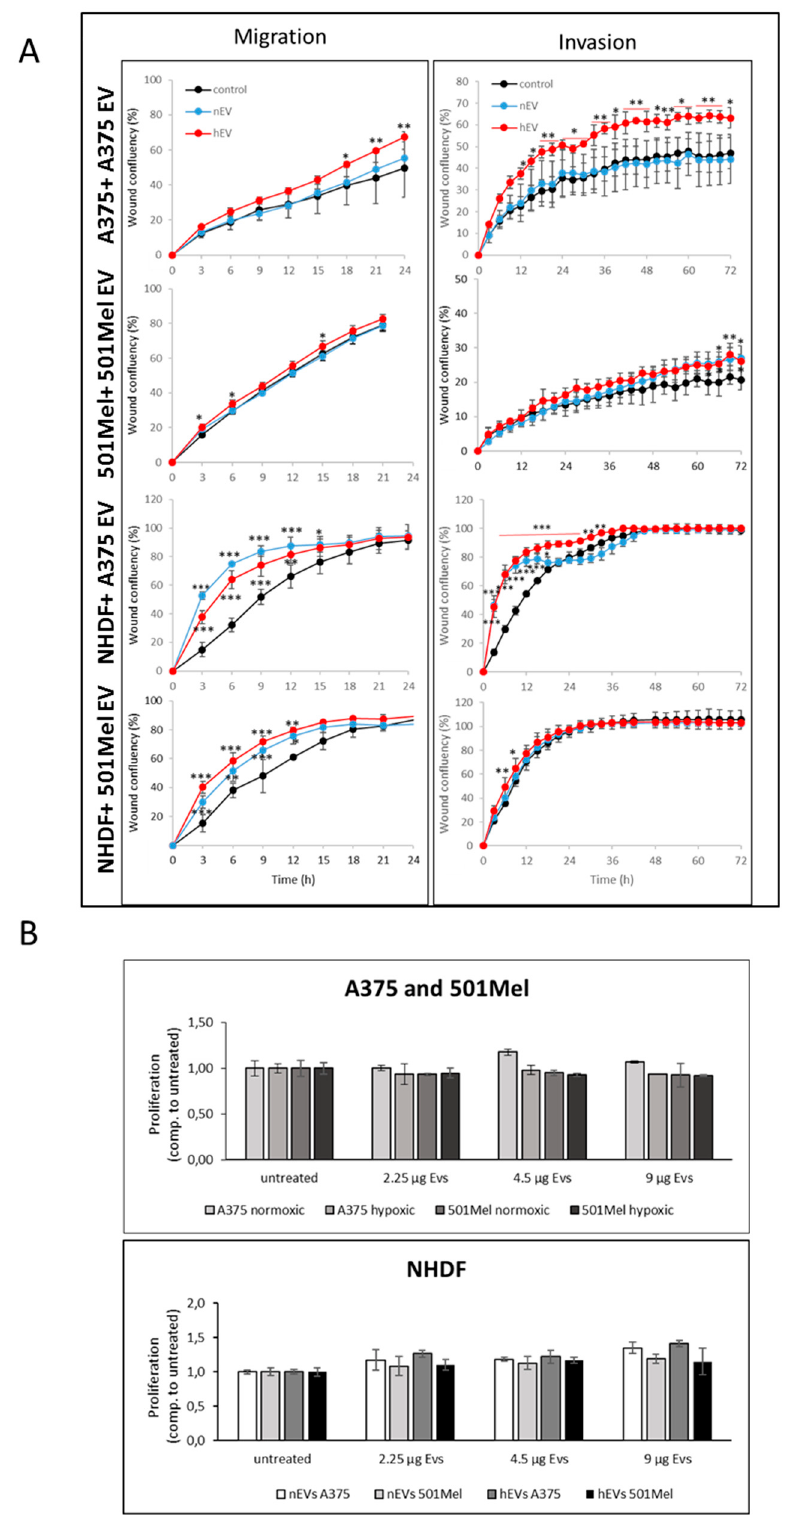
Figure 7. ( A ) Invasion-migration assays. Melanoma nEVs and hEVs from A375 or 501Mel cells were added to their respective cells of origin or to NHDFs. Migration was monitored for 24h and invasion for 72h. * p < 0.05, ** p < 0.01, *** p < 0.001, compared to control treatment. ( B ) Proliferation assays. Melanoma nEVs and hEVs (A375 or 501Mel) were added to melanoma cells (A375 or 501Mel) or to NHDFs. Proliferation was monitored 48 h after EV addition.